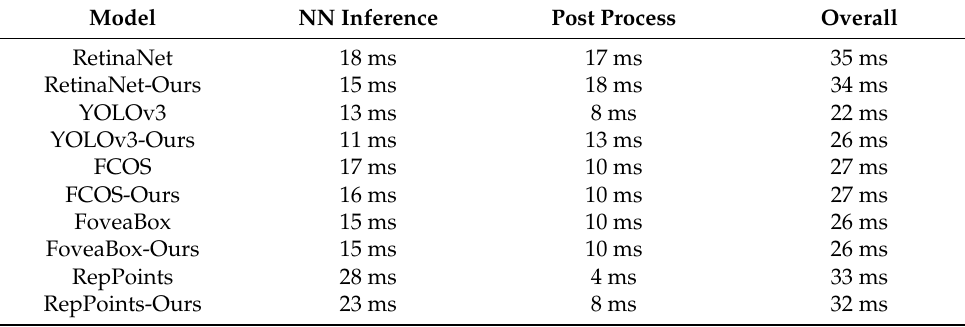
Table 11. Model Inference Time Per Frame of NVIDIA Tesla V100.